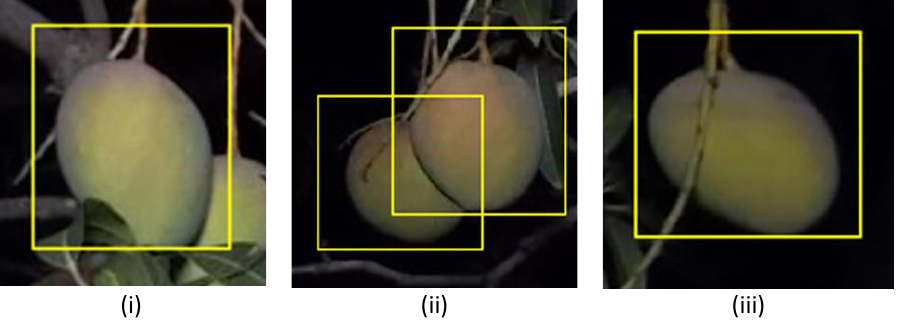
Figure 8. An example output image using Method 2, criteria set B. Fruit enclosed with green bound- ing box and blue ellipse are non-occluded fruits and considered for sizing. Fruit enclosed by red ellipse are occluded or failed to fulfil criterion set.